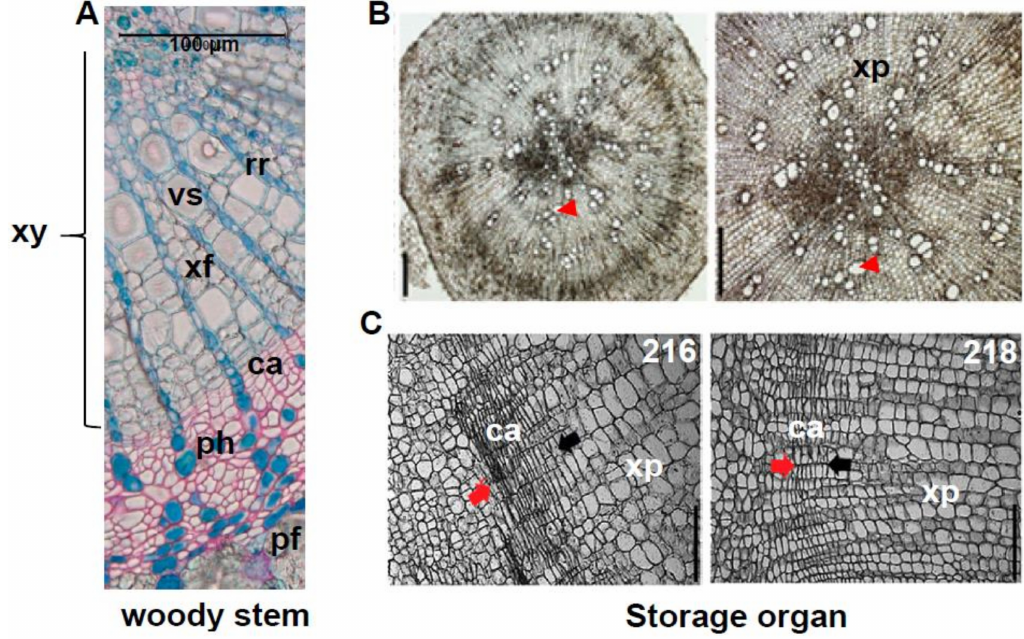
Figure 5. Cross-sections of birch ( Betula pendula ) stem ( A ) and storage organs of radish ( Raphanus sativus) ( B , C ). Angiosperm wood is composed of xylem fibres and vessels to a large extent ( A ), while there is a substantial number of xylem parenchyma cells in the radish of three-week-old line 216 ( B ). The red arrow head indicates one of the xylem vessel cells. The size bar is 200 µ m ( B ). The line 216 ( left ), which generates the larger storage organ, harbours a wider cambial zone when compared with the line 218 ( right ). Cambium zones are marked by red and black arrows with the red arrows on the side of the cortex region. The size bar is 100 µ m ( C ). Abbreviations: xy—xylem;